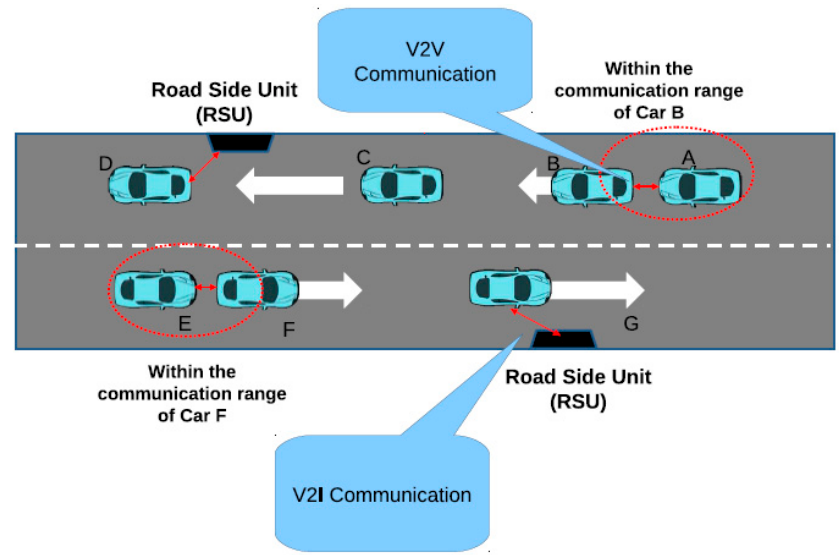
Figure 3. Communication in VANET using V2V, V2I, and I2I [19].